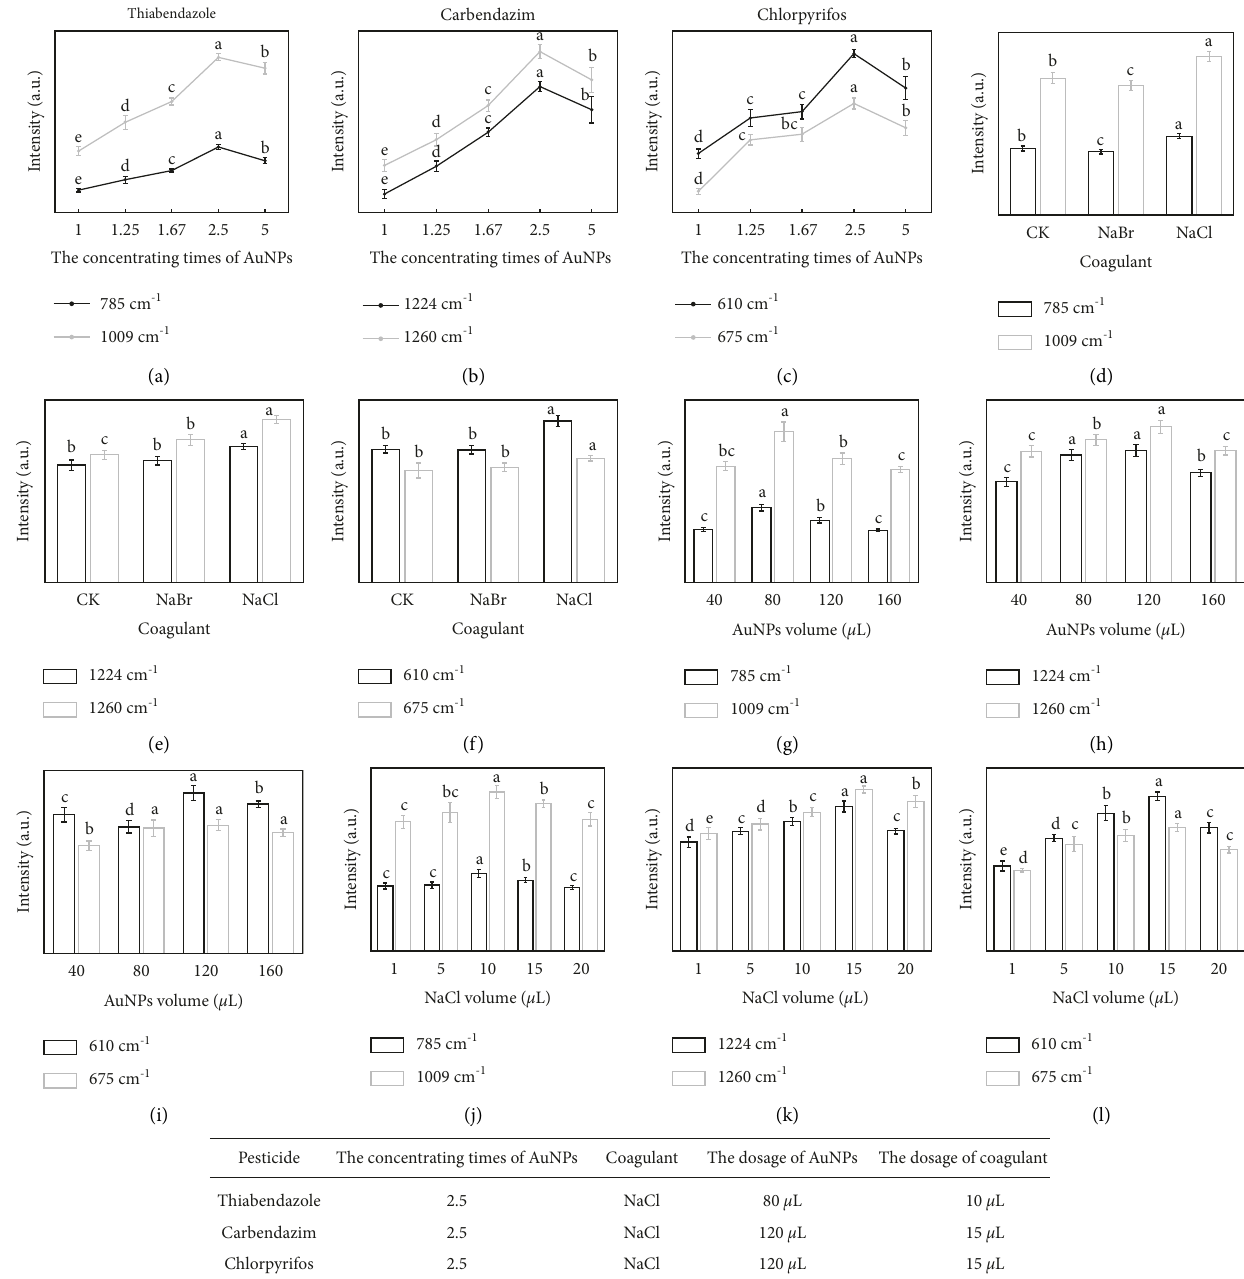
Figure 4: SERS signal of characteristic peaks with (a–c) different AuNPs concentrations, (d–f) different coagulants, (g–i) different AuNPs dosages, and (j–l) different NaCl dosages. (m) Summary of optimal parameters for each pesticide. CK represents the group without coagulants. (a), (d), (g), (j) The results of thiabendazole; (b), (e), (f), (k) the results of carbendazim; (c), (f), (i), (l) the results of chlorpyrifos. Different color depths represent different characteristic peaks. Bars and points indicate the means Within the same characteristic peak, any two bars or points with different letters are statistically significant according to ANOVA (Tukey post hoc test, P <